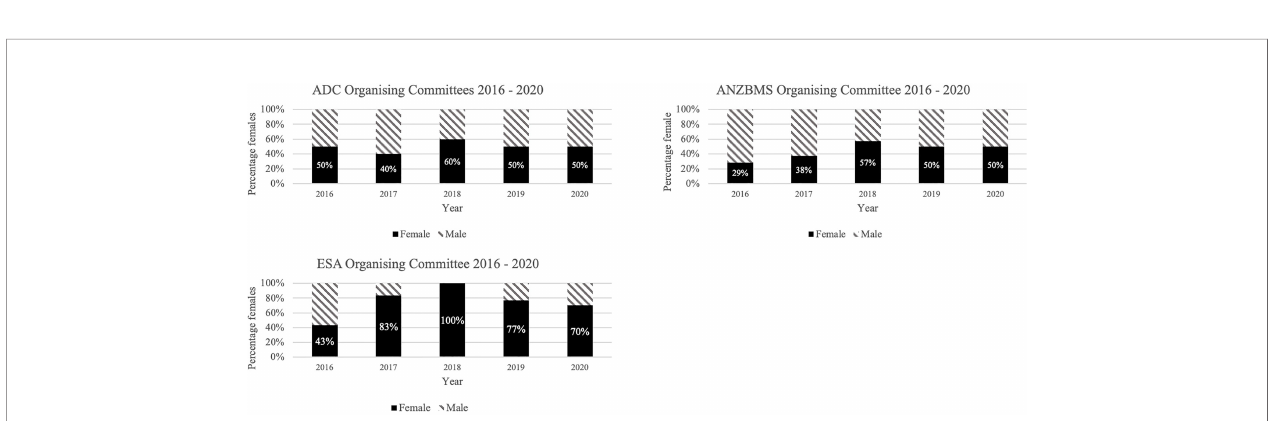
FIGURE 2 | Percentage of female session chairs. ADC, Australasian Diabetes Congress; ANZBMS, Australian and New Zealand Bone and Mineral Society; ESA, Endocrine Society of Australia.